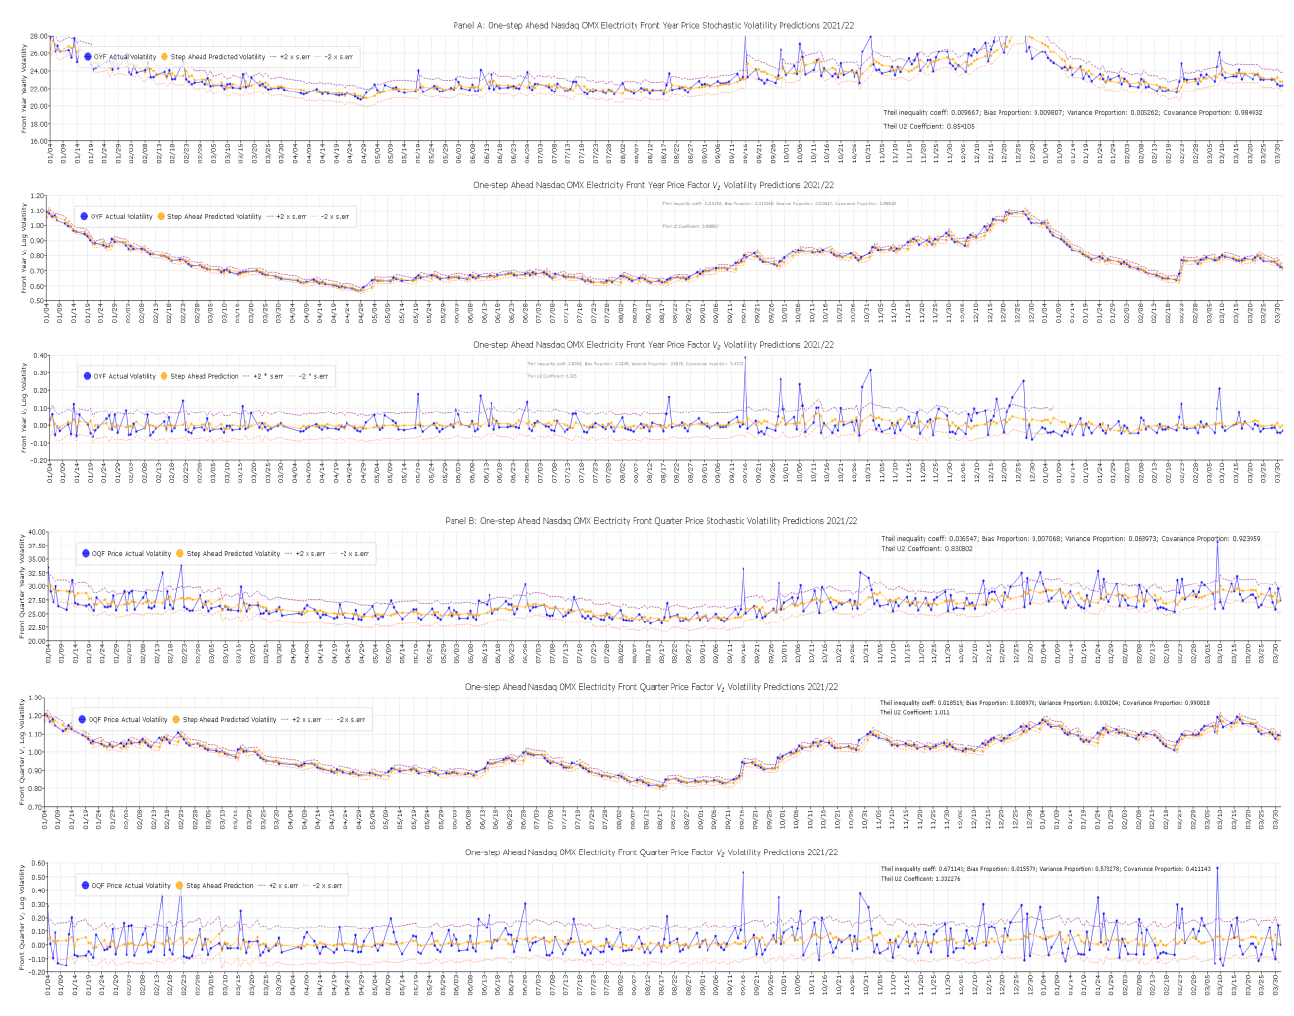
Figure 7. Nasdaq OMX Front Year ( top ) and Front Quarter ( bottom ) Contracts Static Forecasts for 2021/22.